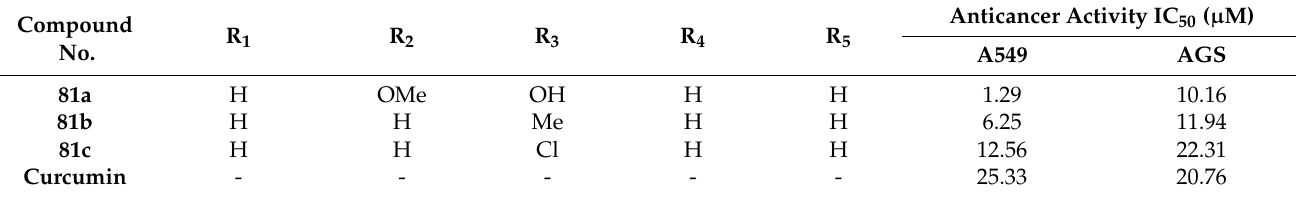
Figure 78. Structure of curcumin-sulfonamide derivatives ( 81 ). Table 67. In vitro cytotoxic activities of curcumin-sulfonamide hybrid compounds 81 ( a – d ).